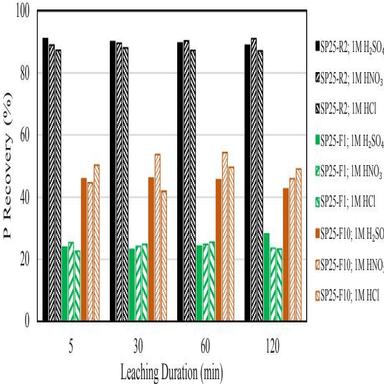
Leaching recoveries of phosphorous from the Guxu core samples.